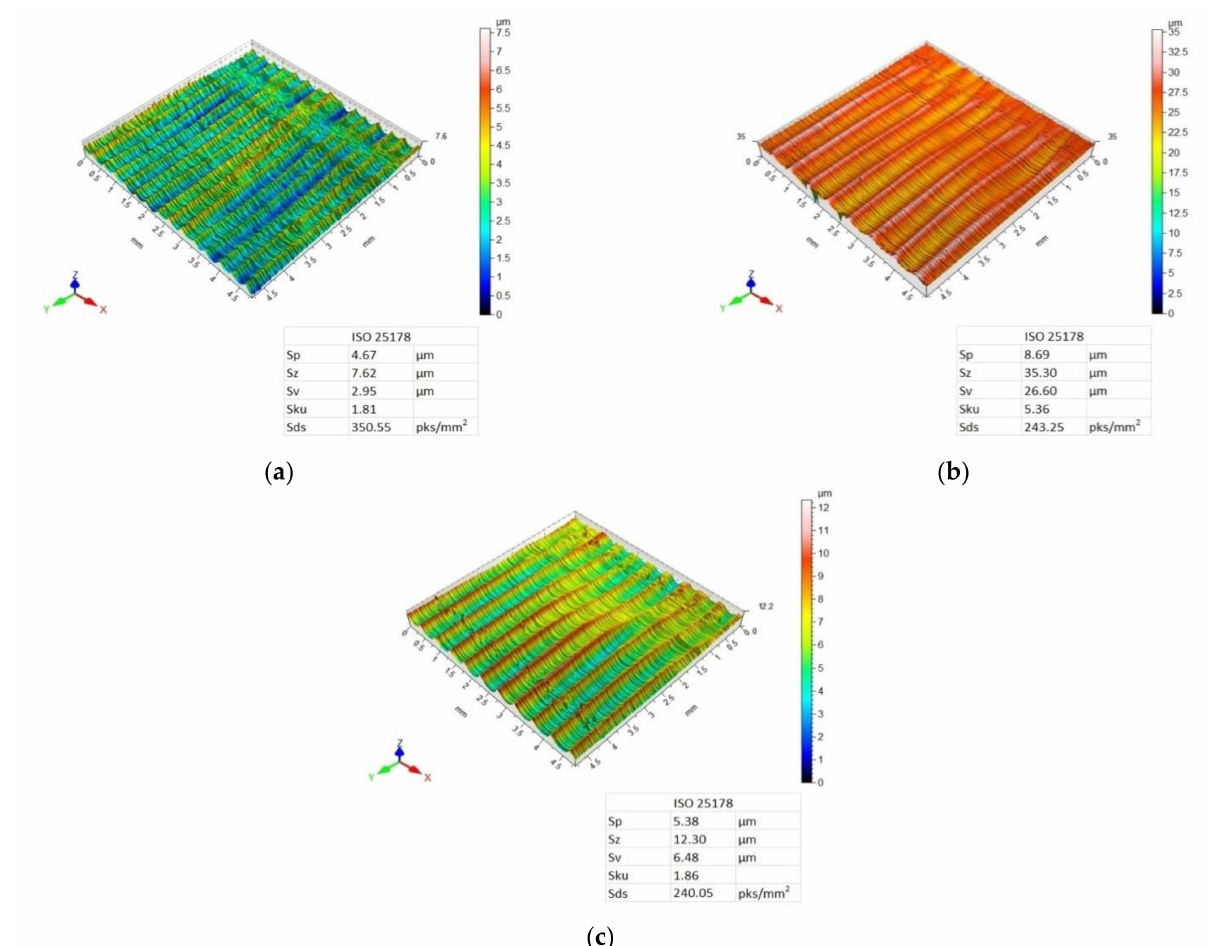
Figure 9. Surface topography of aluminium alloy after milling using CFRP/Al strategy and feed rate: ( a ) f z = 0.04 mm/blade, ( b ) f z = 0.08 mm/blade, ( c ) f z = 0.12